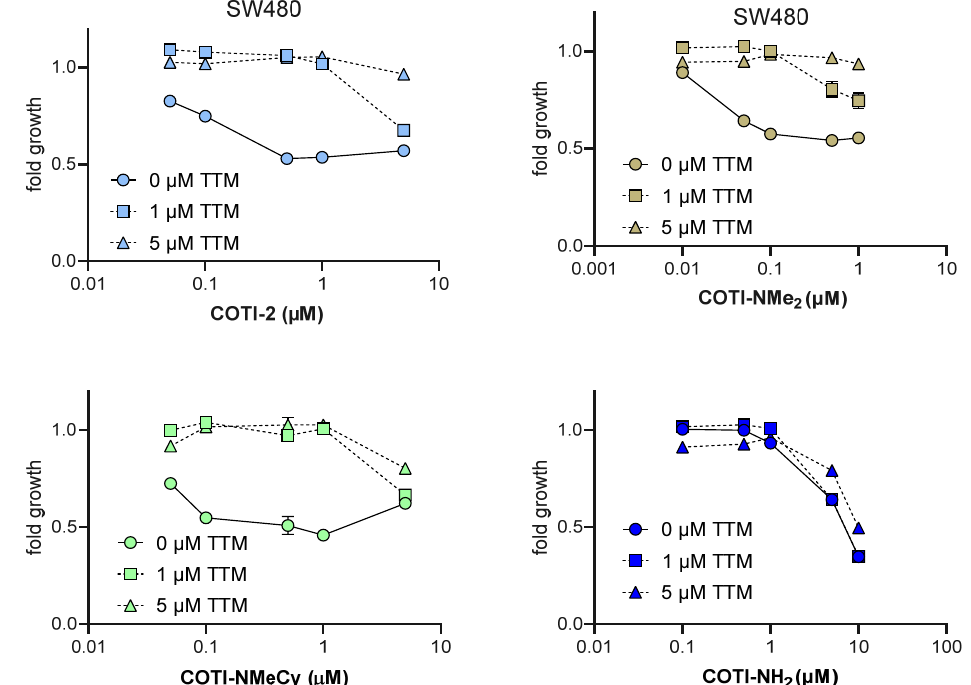
Figure 9. Impact of tetrathiomolybdate (TTM, 1 µM, and 5 µM) on the anticancer activity of COTI- 2 and its derivatives in SW480 cells. Viability was measured by MTT assay after 72 h of combined drug treatment. The mean ± SD was derived from triplicates of one representative experiment out of